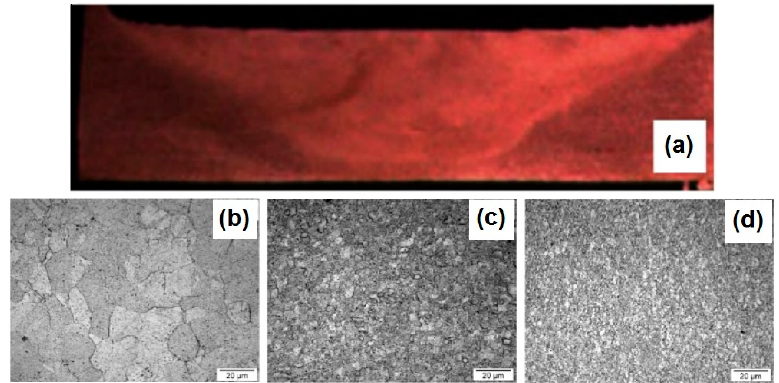
Figure 4. Optical images of single-pass FSPed copper alloy (reproduced from [47], with permission from Elsevier, 2011) ( a ) macrostructure; ( b ) base material; ( c ) nugget regions of specimens processed at 50 and ( d ) 250 mm/min. Table 2. Experimental data on FSP of copper alloys.